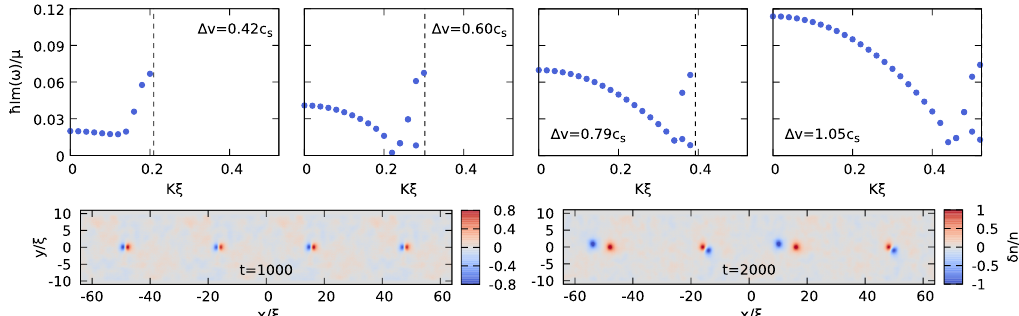
Figure 7: Upper panels: Plots of the instability rates analogous to Figure 2, for = 20 ξ and smaller relative velocities ∆ v . While lowering ∆ v , the system goes L y from a KHI regime (last panel ∆ v = 1.05 c dominated by the modes near the edge of the Brillouin zone and is essentially inde- pendent of the velocity. Lower panels: Snapshots of the late time evolution of the density variation obtained by solving the GPE for ∆ v = 0.2 c first snapshot at t = 1000 µ/ ħ h shows the DI dominating at small velocities at early times, while the second one at t = 2000 µ/ ħ h shows the subsequent development of a